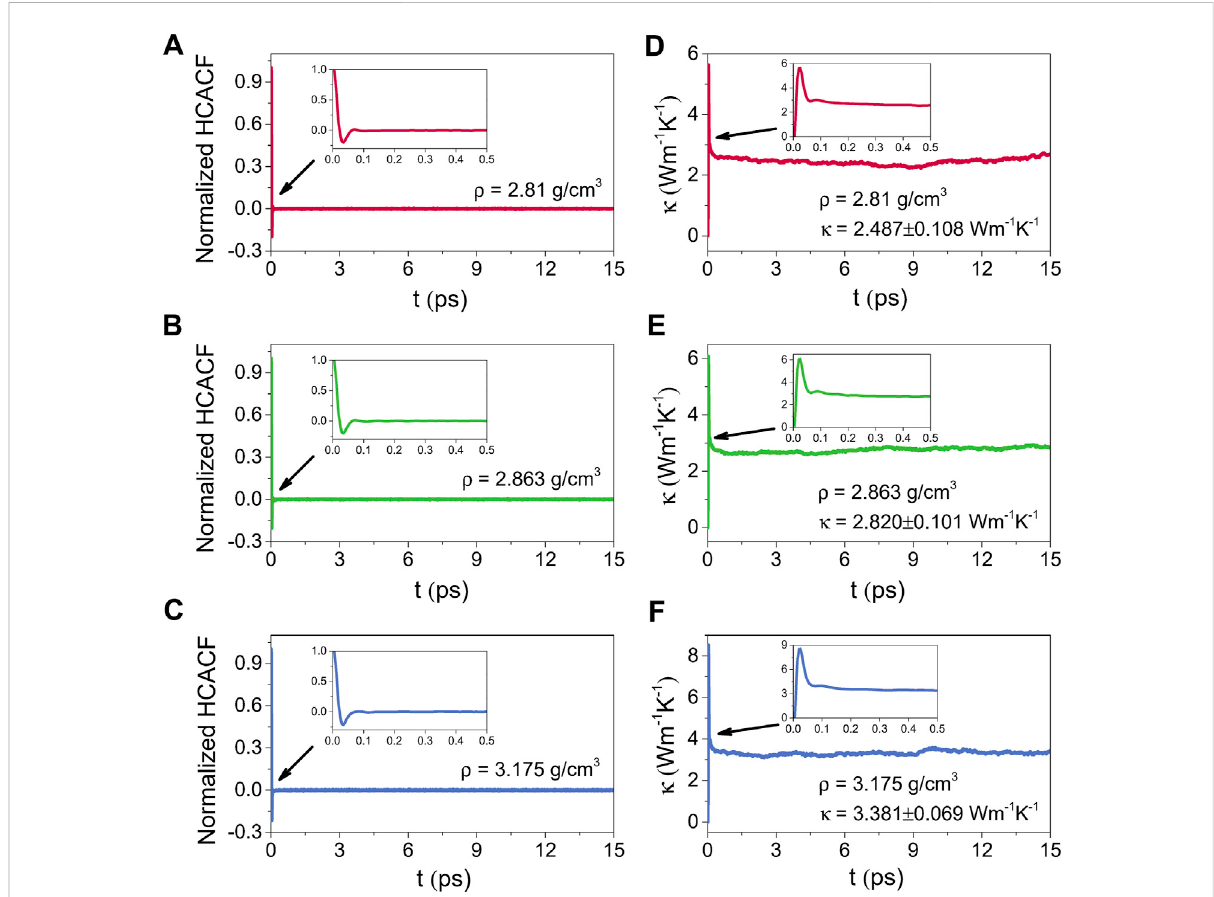
FIGURE 11 NormalizedHCACFs for (A) ρ =2.81 g/cm 3 , (B) ρ =2.863 g/cm 3 and (C) ρ =3.175 g/cm 3 ,and thermalconductivities( κ )for (D) ρ =2.81 g/cm 3 , (E) ρ =2.863 g/cm 3 and (F) ρ =3.175 g/cm 3 asafunctionofthecorrelationtimeforliquidaluminaat2500 K,insets:thenormalizedHCACFsandthermal conductivity curves over the correlation time of 0 – 0.5